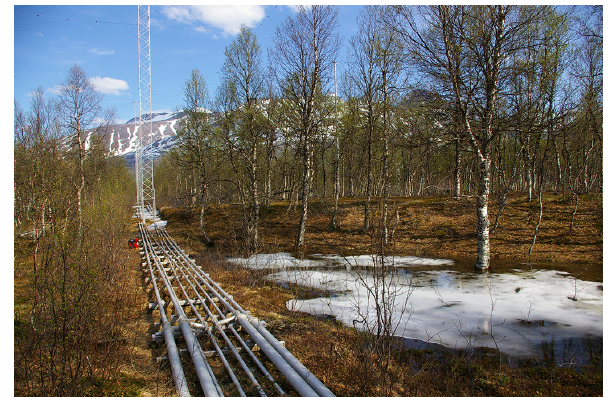
Figure 4. Three important people involved in the construction of Heating. The photograph shows, from left to right, technician Hel- mut Gegner and scientists Jules Fejer and Helmut Kopka in the transmitter hall in 1979. Four open 100kW transmitters are visible, which were used in the first experiments. (Photo credit: